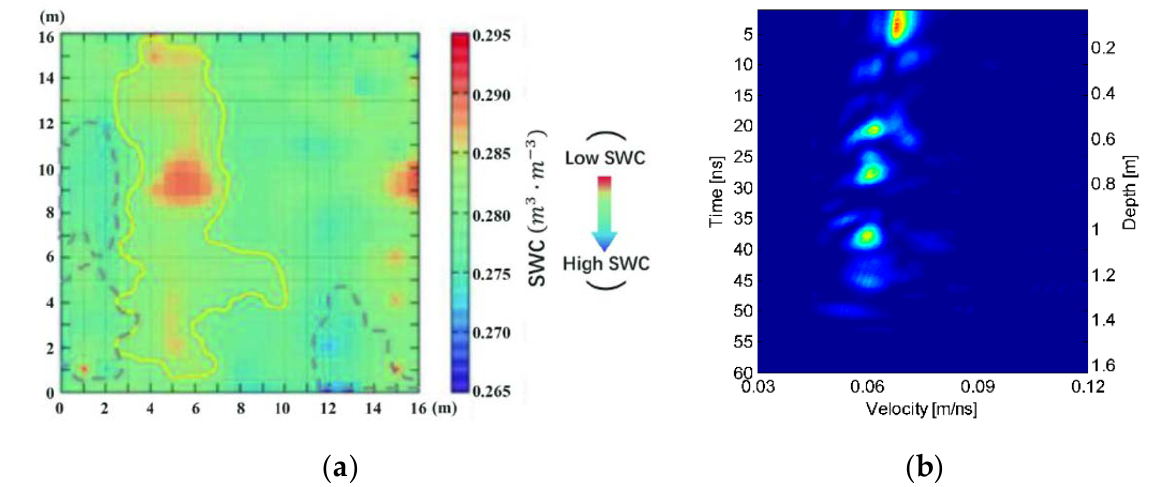
Figure 7. GPR prospecting for SWC estimation. ( a ) SWC distribution determined by the surface reflection method [170]. ( b ) Velocity spectrum resulting from common mid-point acquisition [189].